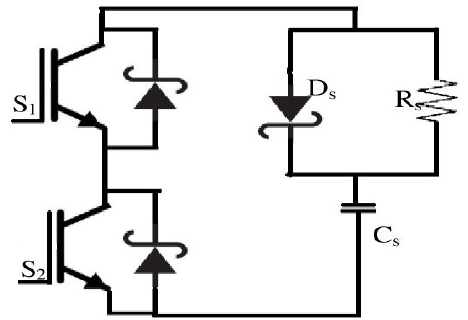
Figure 2. Circuit diagram of the RCD snubber [8].